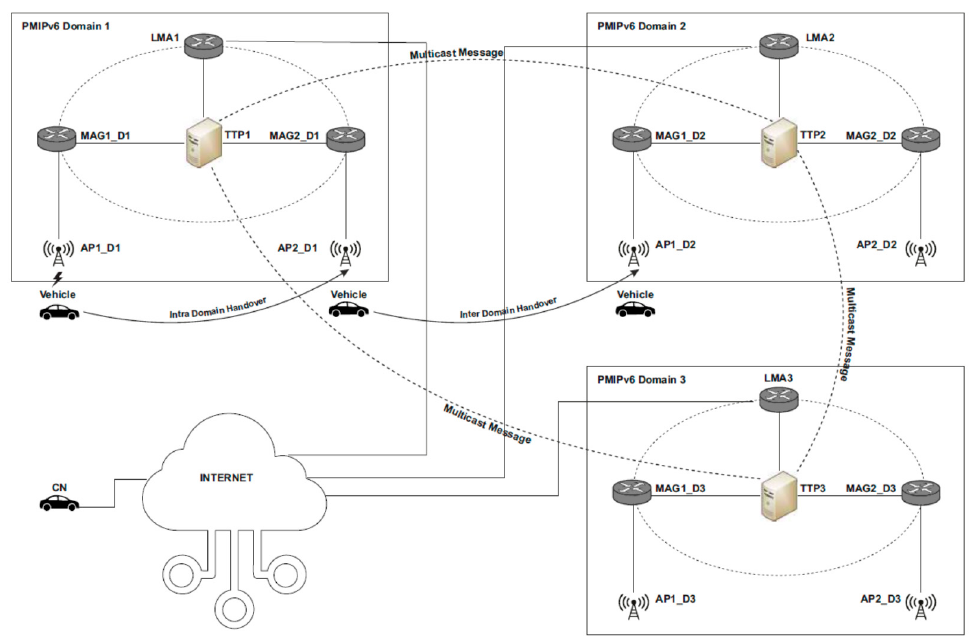
Figure 2. Multicast-enabled architecture for handover for